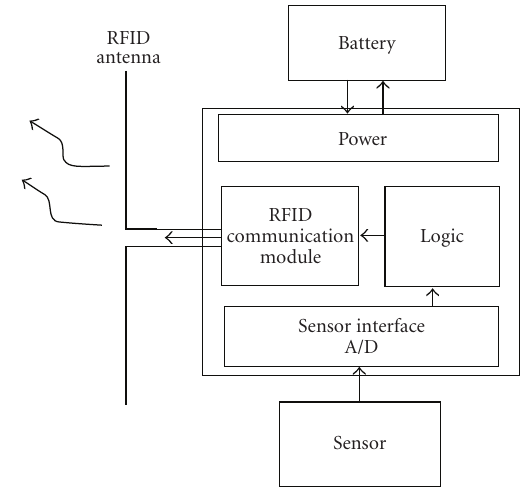
Figure 13: Diagram of RFID/sensors tag.